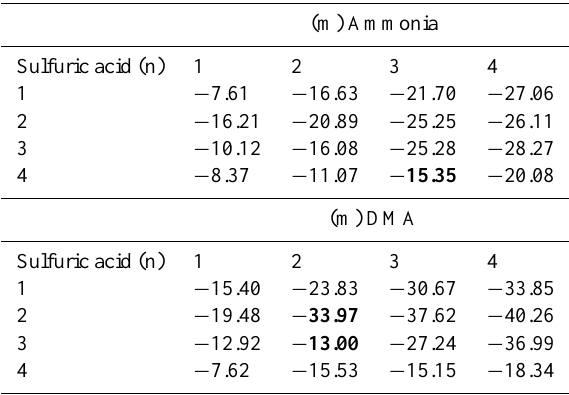
Table 3. Gibbs free energy for the reaction ((H 2 SO 4 ) n − 1 (NH 3 / (CH 3 ) 2 NH) m + H 2 SO 4 → (H 2 SO 4 ) n (NH 3 / (CH 3 ) 2 NH) m ) in kcalmol − 1 at 298.15K.